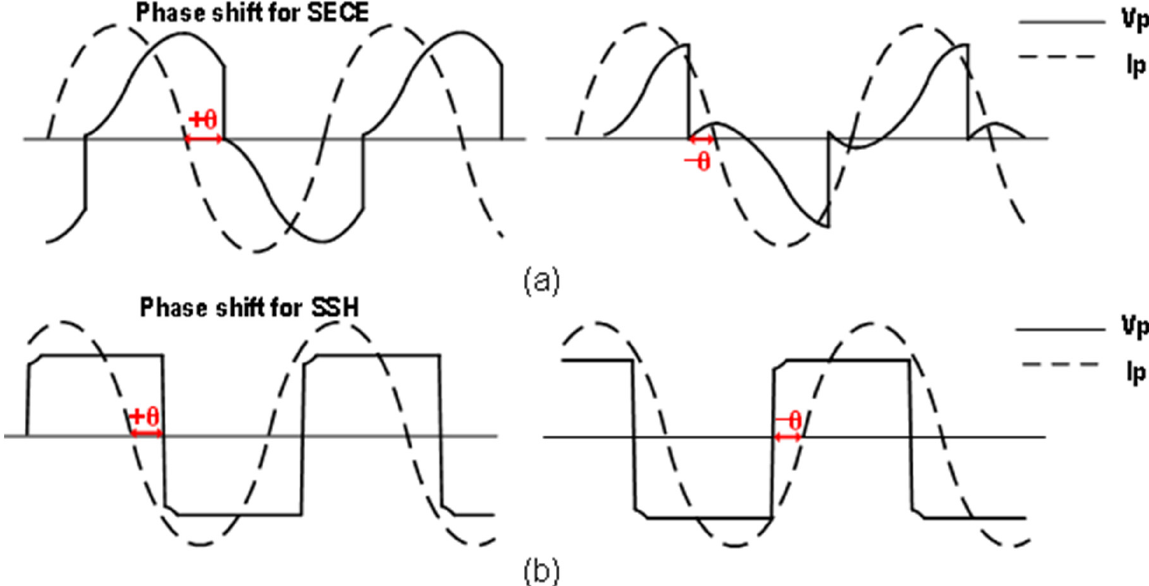
Figure 18. Illustrative diagram showing phase shift for ( a ) the SECE, and ( b ) the SSHI.